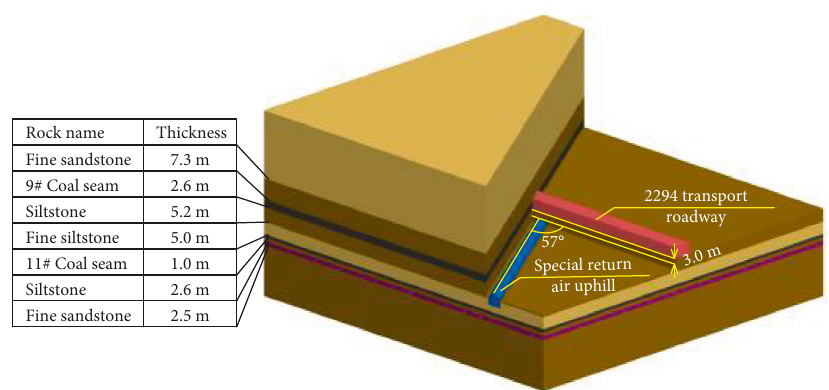
Figure 1: Schematic diagram of roadway spatial staggered layout.